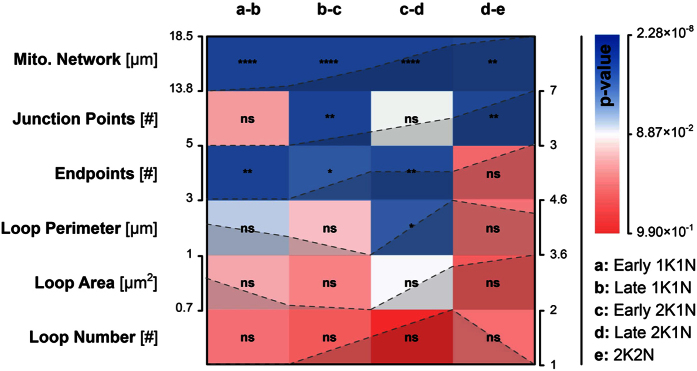
Heatmap matrix of mitochondrial growth during the cell cycle.Features including mitochondrial network size and number of endpoints were tested for significant changes from one cell cycle stage to the next (2-tailed unpaired student’s t-test). Each row represents one feature and each column represents two consecutive cell cycle stages (a–e). The colour code and the asterisks (****p-value < 0.0001, ***0.0001 < p-value < 0.001, **0.001 < p-value < 0.01, * = 0.01 < p-value < 0.05, ns = p-value ≥ 0.05) represent the obtained p-value and the significance level respectively. The tested features were arranged in descending order according to their average p-value. The dashed lines in the matrix show the trend of the calculated median values for each cell cycle stage–the corresponding axis (left or right of the matrix) show the range of these values.